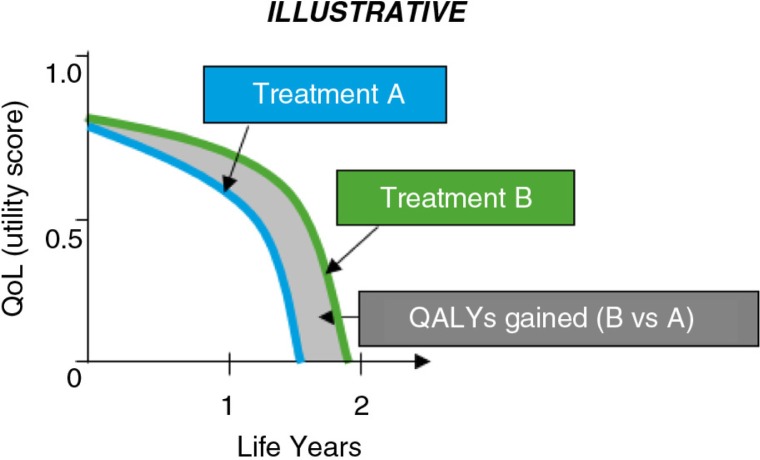
Comparison of quality-adjusted life years (QALYs) across two hypothetical treatments (A and B).